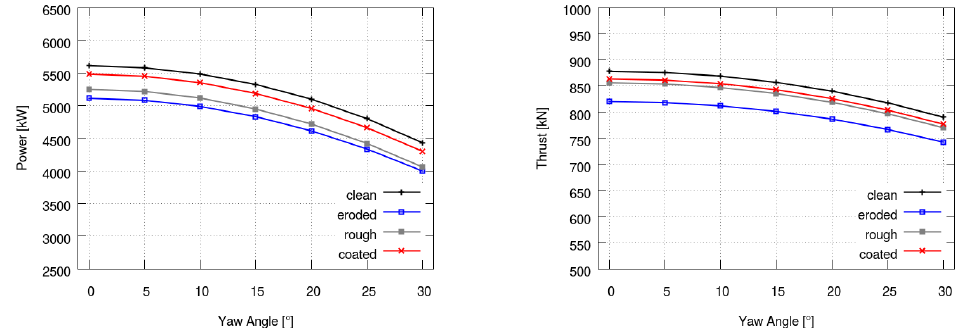
Figure 12. Rotor power and thrust against yaw angle of the NREL 5 MW turbine at rated condition using different sets of polars for the NACA 64-618